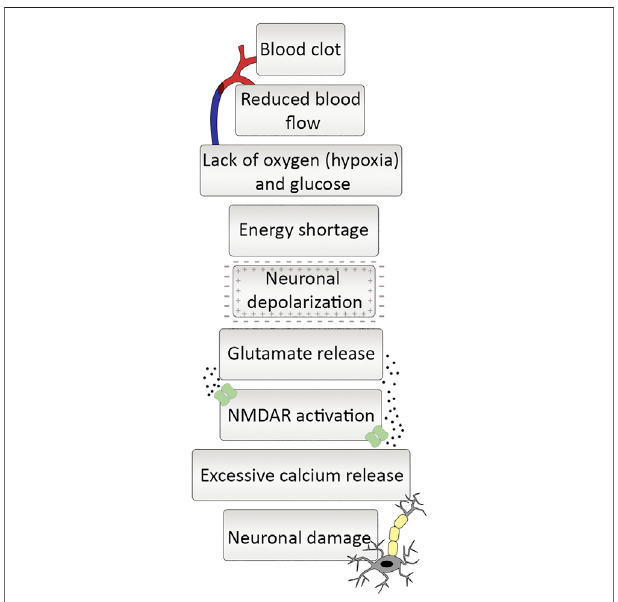
FIGURE1| Ischemiccascadeataglance.Occlusionofanarterystartsa series of responses. Blood clot blocking artery causes reduced blood fl ow, whichleadstolackofoxygenandglucoseandultimatelyadrasticdecrease in energy supply. It leaves neurons in a depolarized state and reduction in glutamate reuptake gives rise to increase in extracellular glutamate levels. The increment in glutamate leads to NMDA receptor activation and neuronal calcium in fl ux, and excessive amount of calcium release ending up with neuronal